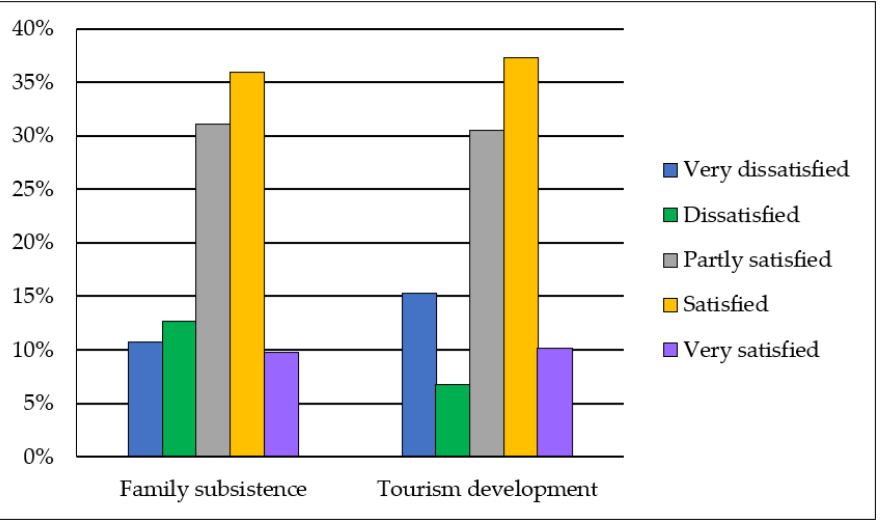
Figure 2. Crosstabulation between economic impact and business satisfaction level.